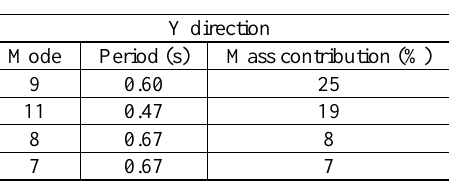
Table 4 . Modal analysis